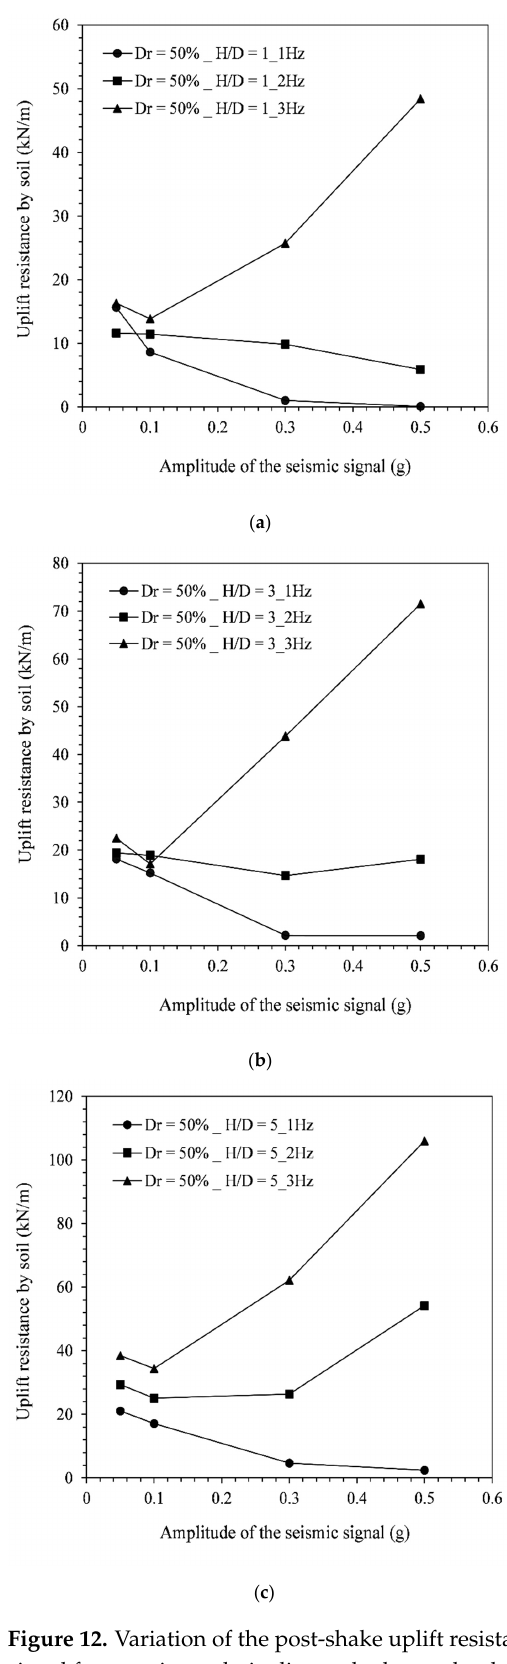
Figure 12. Variation of the post-shake uplift resistance with the earthquake amplitude for different signal frequencies and pipeline embedment depth ratios (H/D) of ( a ) 1, ( b ) 3, and ( c ) 5. The variation of the post-peak uplift resistance of the Nevada sand with the pipeline embedment depth is shown in Figure 13. The abscissa represents the pipeline embedment depth, while the ordinate represents the post-shake uplift resistance of the pipeline. It can be observed that, irrespective of the soil and seismic signal parameters, the post-peak uplift resistance increased with an increase in the embedment depth. With the increase in embedment depth, the boundary of the failure surface and the soil volume above the pipeline increased. Thus, the shear resistance along the failure boundary and the weight of the failed soil wedge also increased, which resulted in an increase in the uplift resistance of the soil.